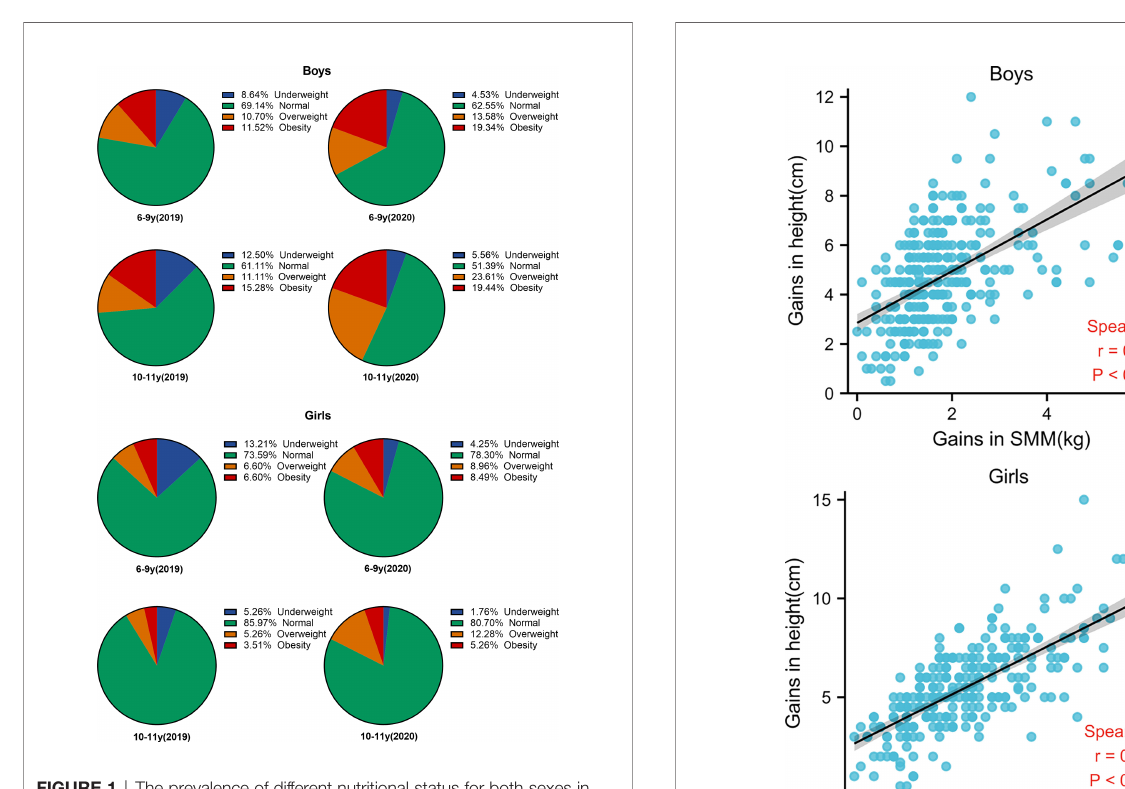
FIGURE 1 | The prevalence of different nutritional status for both sexes in 2019 and